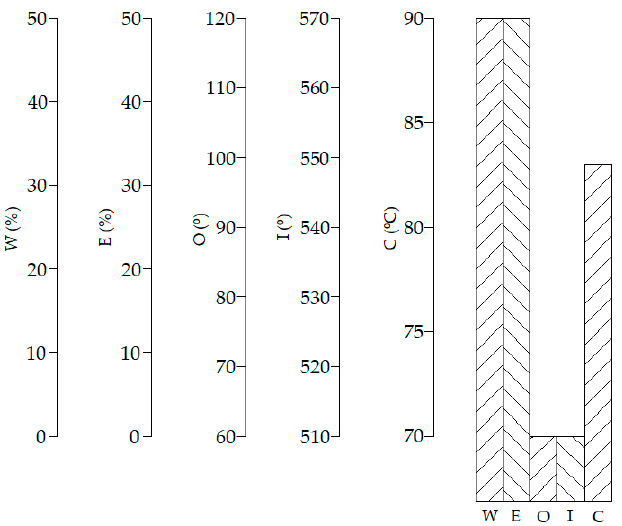
Figure 9. Most appropriate option provided by the hybrid MCDM-ANN model. Table 3. Most appropriate option under several criteria weights for the